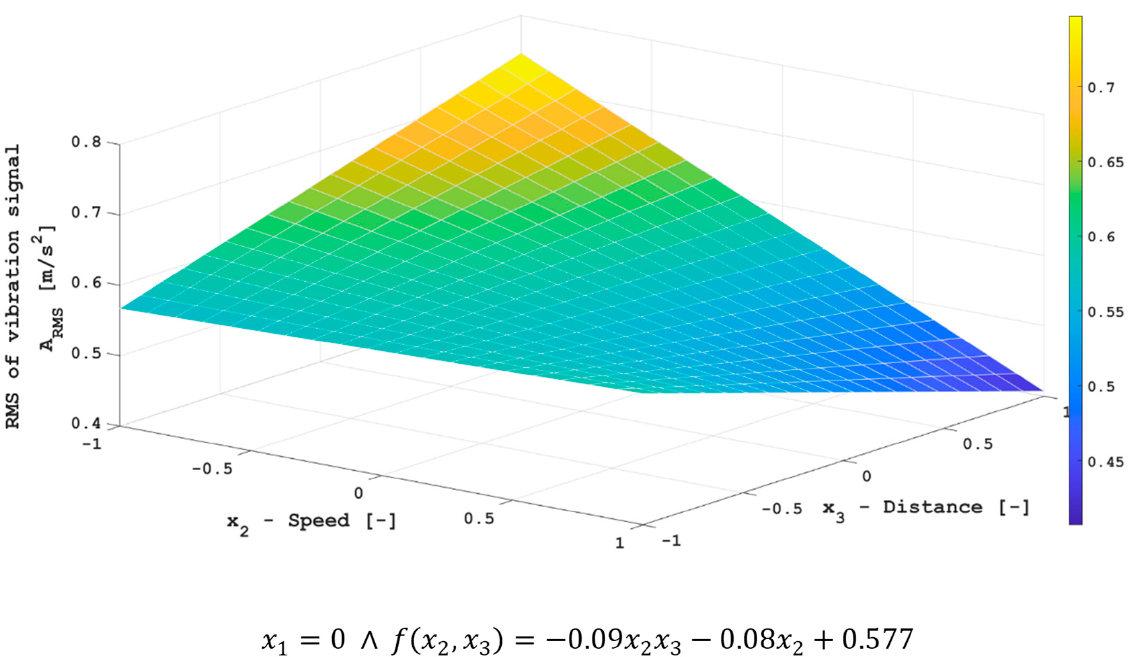
Figure 4. A RMS signal values, depending on the speed of the electric scooter and the distance traveled when moving on a mixed-surface road.